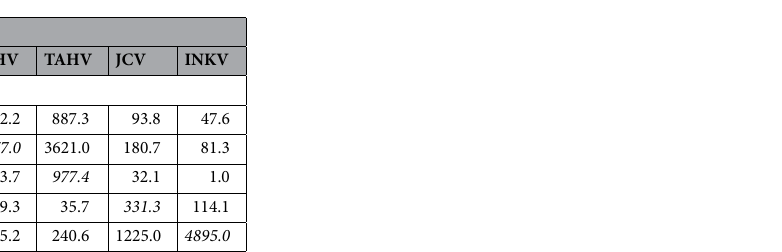
Table 1. Median ND50. Italicized values indicate homologous virus median